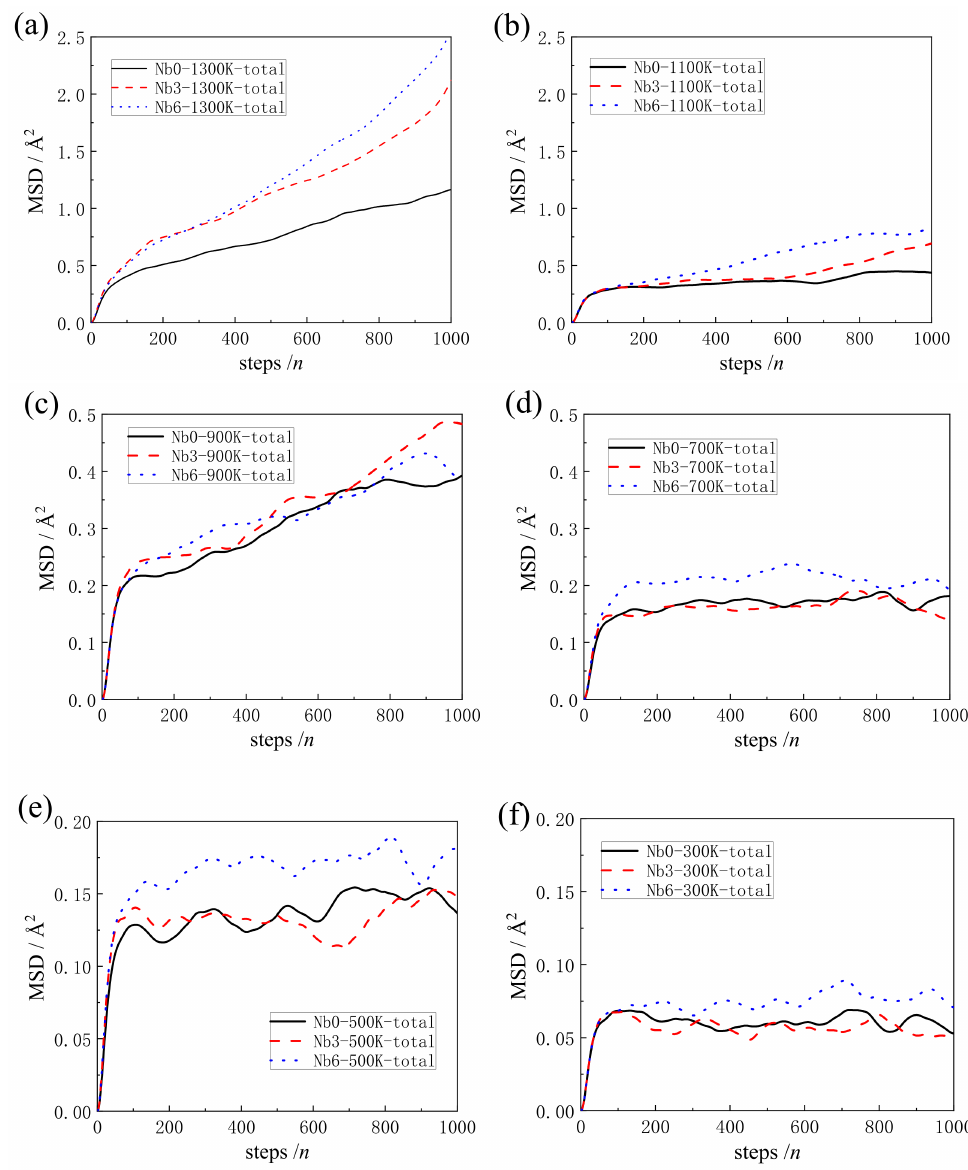
Figure 4. MSD curves of Nb0, Nb3 and Nb6 simulated by AIMD at different temperatures: ( a ) 1300